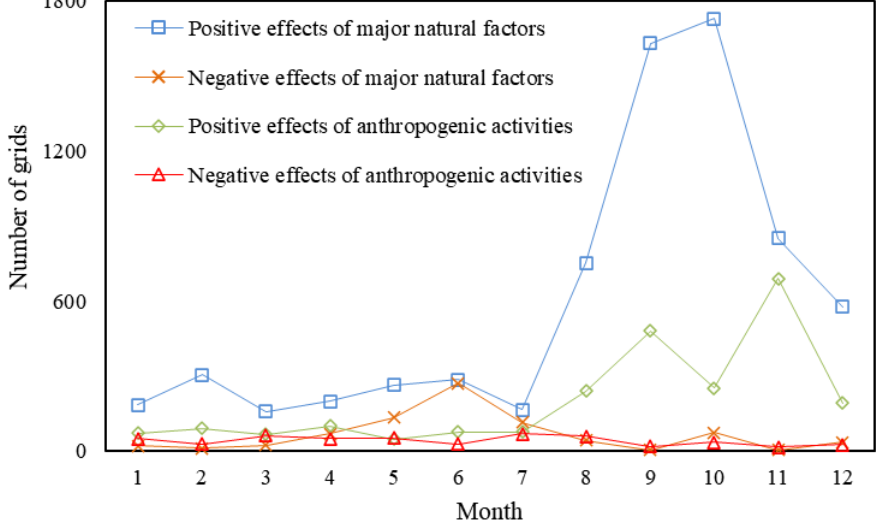
Figure 3. Number of grids with significant changes in vegetation caused by anthropogenic activities and major natural